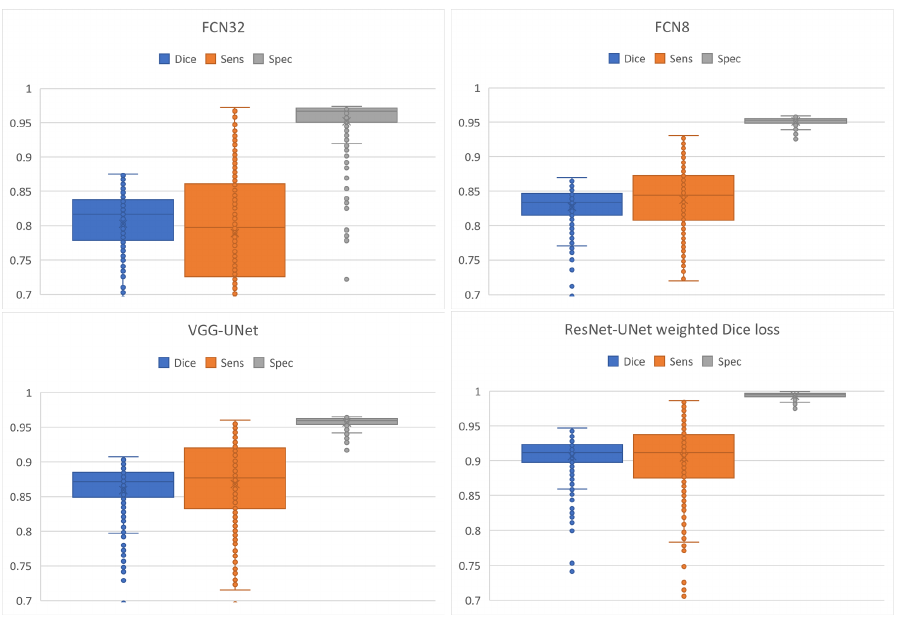
Figure 17. Boxplot comparison of FCN32, FCN8, VGG–UNet and ResNet–UNet. Figure 18 shows a segmentation result from these four networks.